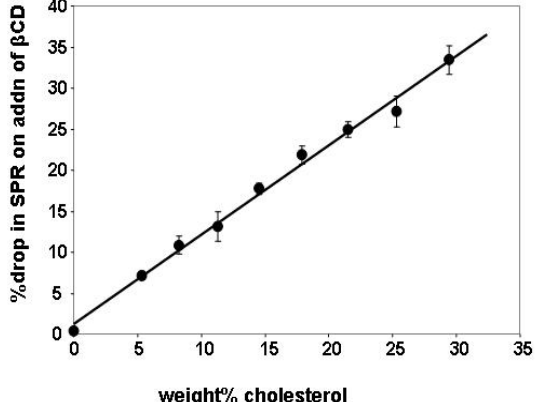
Figure 3. Relative drop in surface plasmon resonance (SPR) signal on β CD addition as a function of the cholesterol composition of the adsorbed liposomes; the straight line is described by the equation y = 1.086 x + 1.305 (R 2 = 0.993). Results represent averages from four different